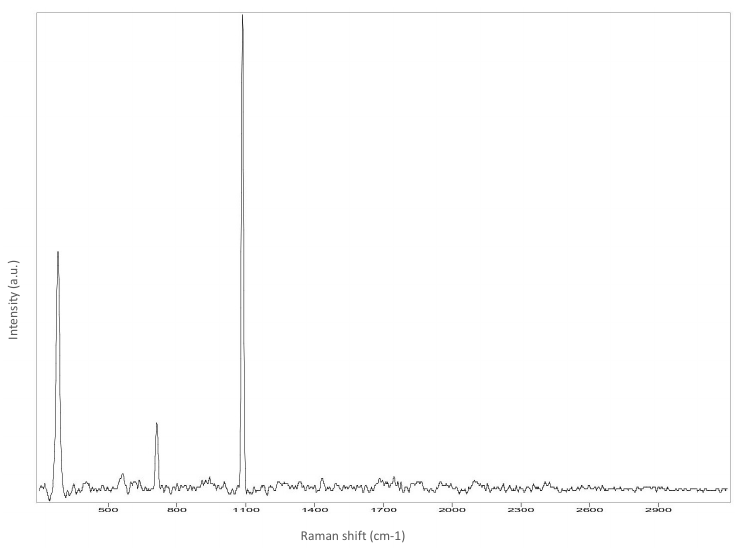
Figure A1. Back-left. Figure A1.